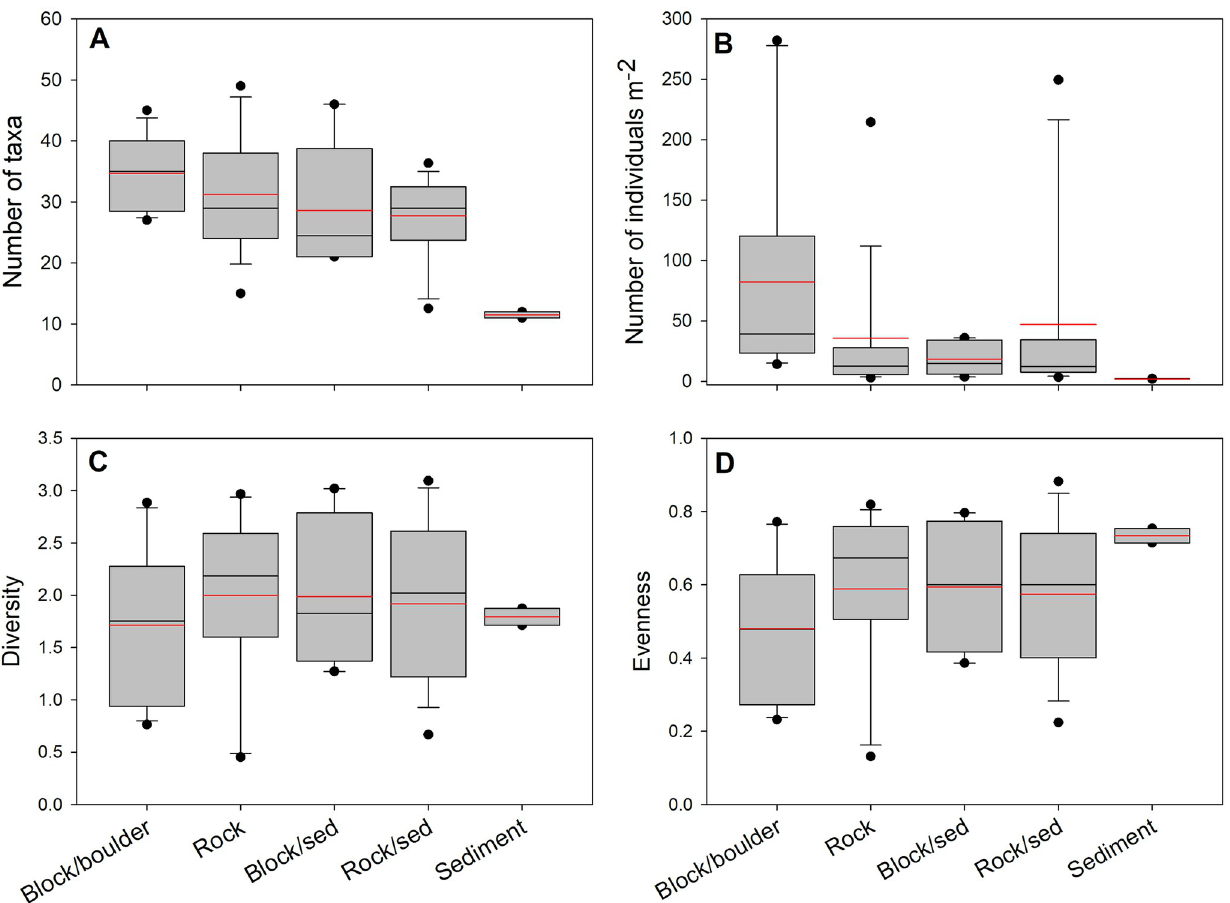
Fig 4. Comparisons of kelp forest community metrics among habitats. A. Taxa richness, B. Numerical abundance (Num. individuals m -2 ), C. Shannon- Wiener Diversity, D. Pielou’s Evenness. Boxes represent 25th, median, and 75th percentiles, and upper and lower quartiles. Black horizontal lines are median and red horizontal lines are mean